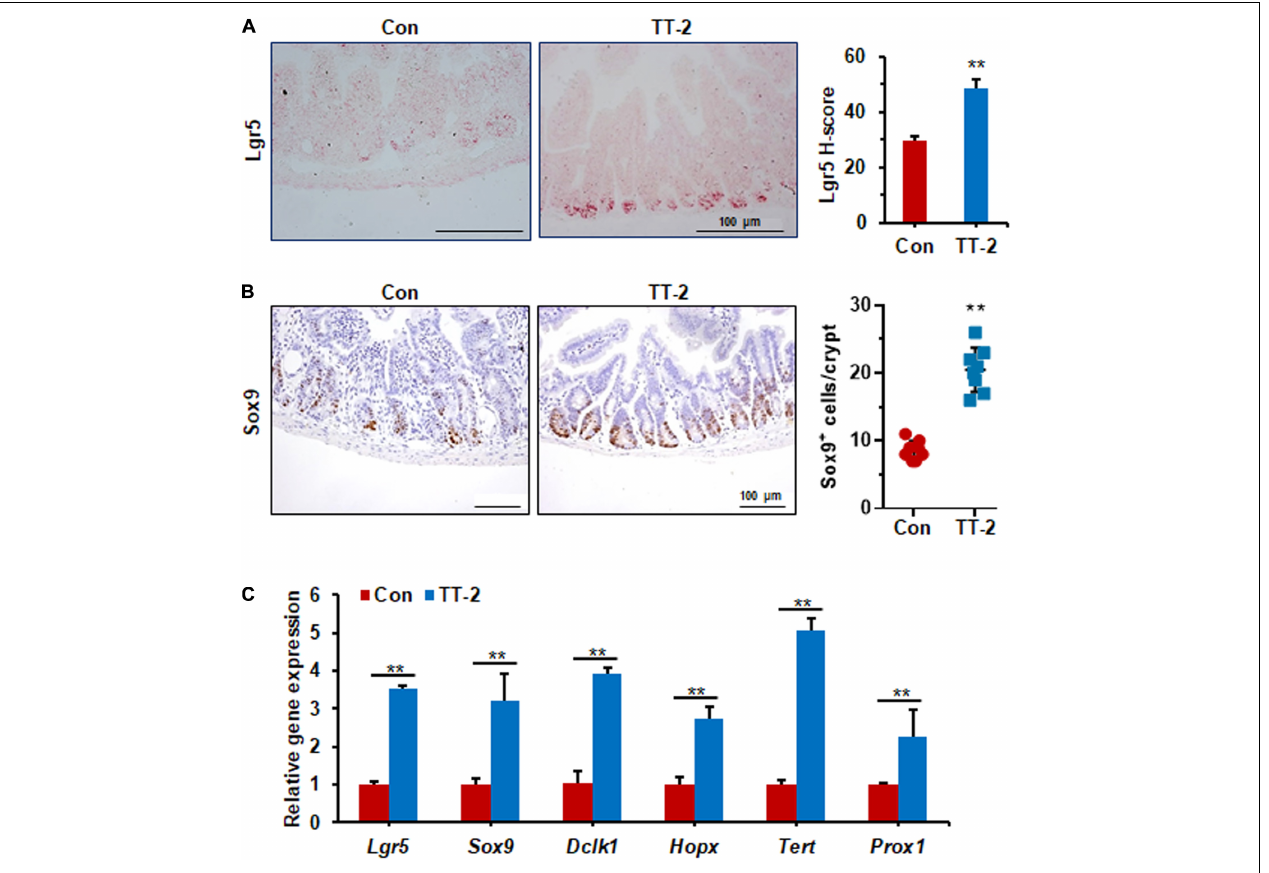
FIGURE 5 | TT-2 promoted intestinal stem cell proliferation of mice after 14 Gy ABI. (A) Representative images of in situ hybridization for Lgr5 mRNA in intestinal crypts after 14 Gy ABI and different treatments (** p < 0.01, scale bar = 100 µ m). Three mice from each group were used. (B) Representative Sox9-stained sections and quantification of Sox9 + cells in crypt of small intestine after 14 Gy ABI and different treatments (** p < 0.01, scale bar = 100 µ m). Three mice from each group were used. (C) qPCR for Lgr5, Sox9, Dclk1, Hopx, Tert, and Prox1 gene expression in mice after 14 Gy irradiation with or without TT-2 treatment for 96 h after ABI (** p <